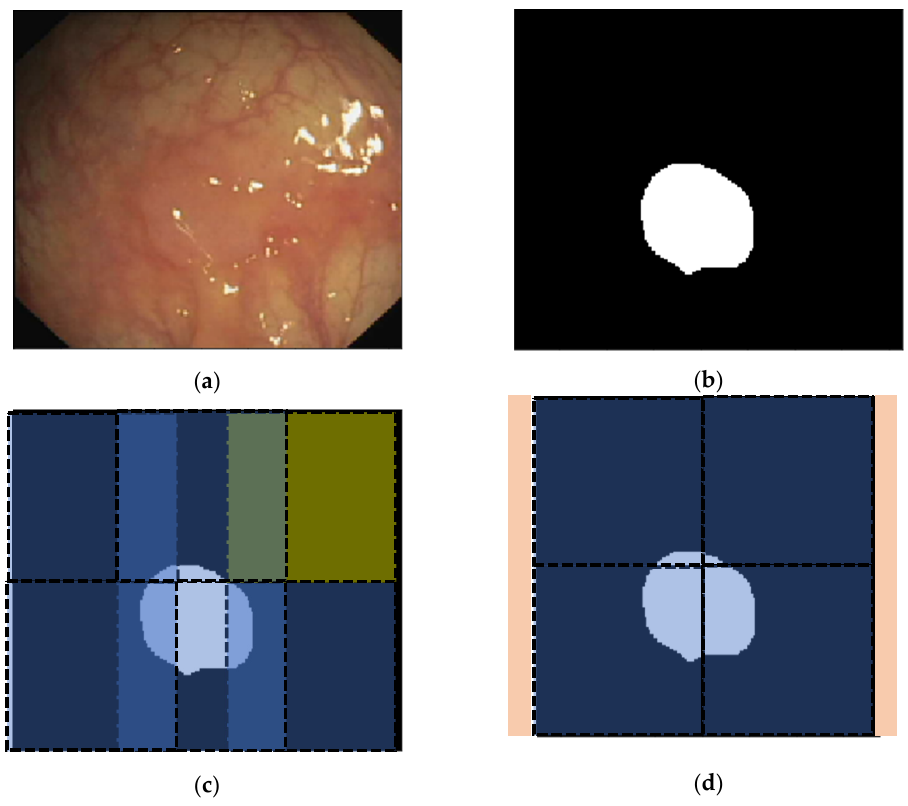
Figure 4. ( a ) A sample CVC ‐ ColonDB image with original size of 574 × 500 pixels; ( b ) the ground truth image for the polyp as the target object, ( c ) extraction of patches with the size of 256 × 256 (the yellow patch does not include any part of the polyp as the ground truth), and ( d ) patch extraction after applying appropriate cropping procedure to the original image (there is no patch without the presence of the polyp as the target object).